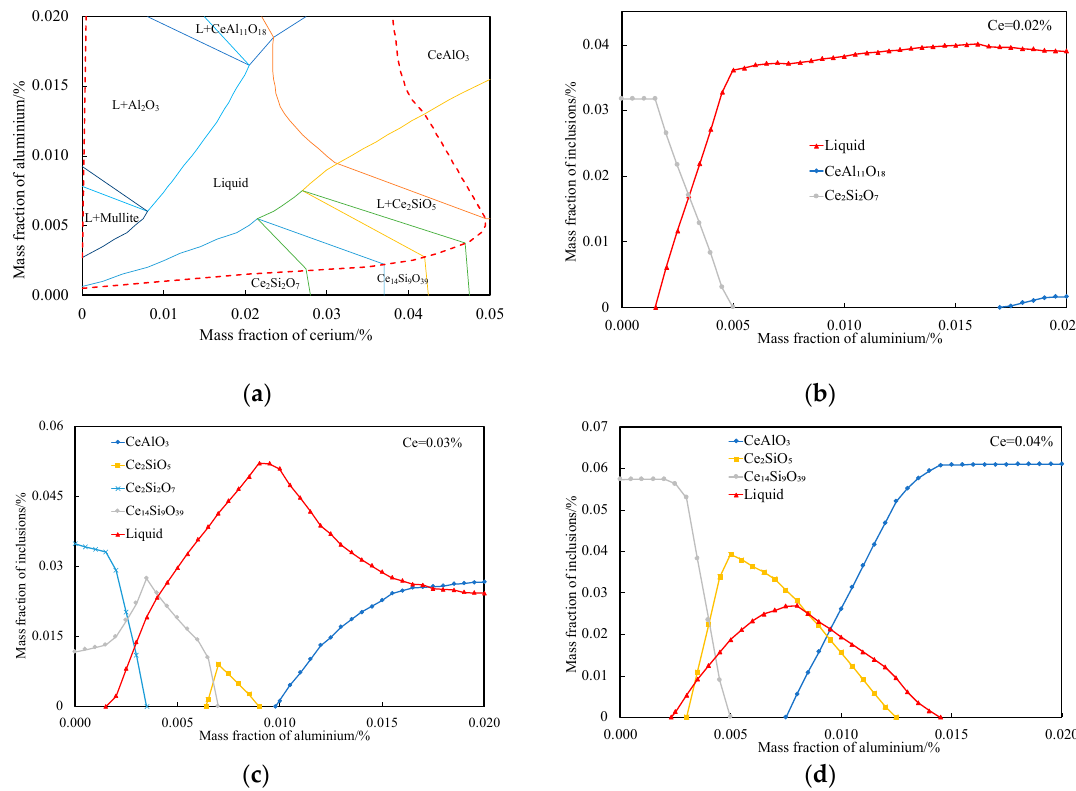
Figure 5. Calculation results by developed thermodynamic package. ( a ) Liquid regions of inclusions; ( b ) E ff ect of aluminum addition on inclusions, w Ce = 0.02%; ( c ) E ff ect of aluminum addition on inclusions, w Ce = 0.03%; ( d ) E ff ect of aluminum addition on inclusions, w Ce = 0.04%.